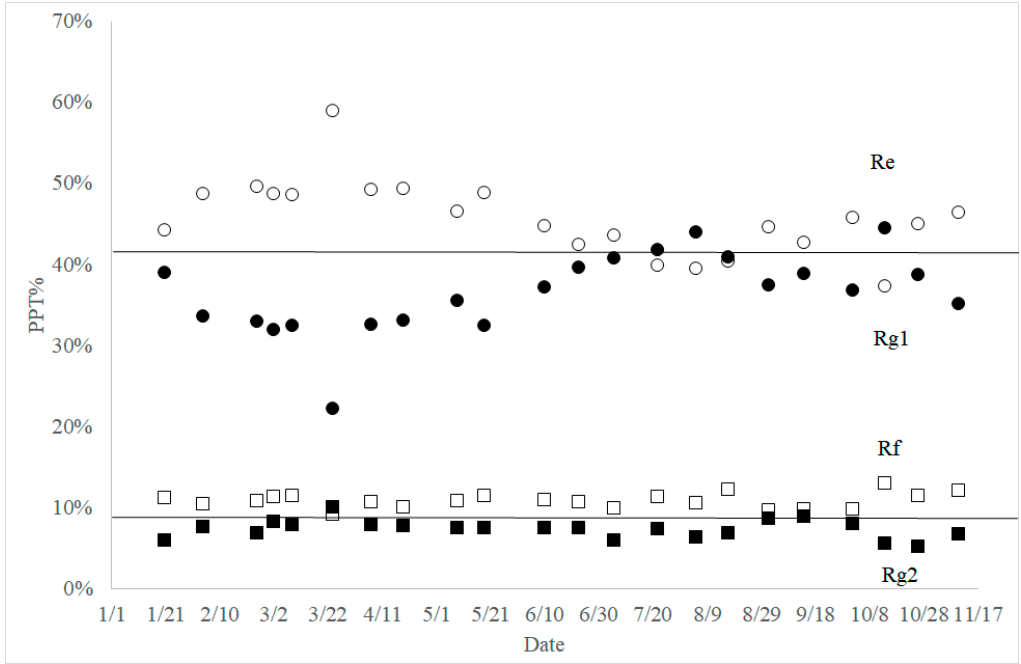
Figure 6. Seasonal composition changes of PPT ginsenosides Re (open circle), Rg1 (closed circle), Rf (open square), and Rg2 (closed square). PPD percentage was calculated from the sum of four PPD ginsenosides.